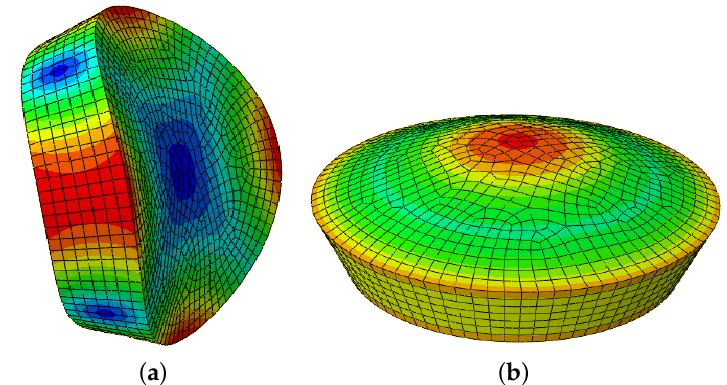
Figure 3. The natural vibration modal deformations of the thick discs, ( a ) the first flexural mode; ( b ) the first compressional